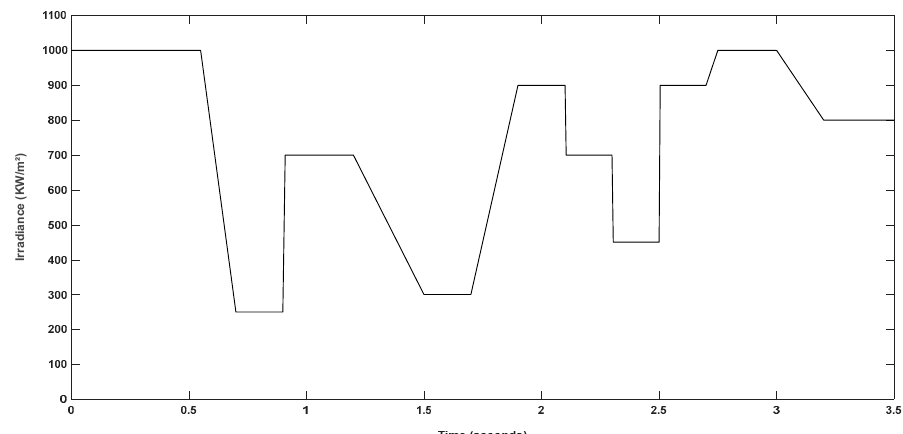
Figure 4. Illumination pro fi le of the uniform solar irradiance condition (USI).